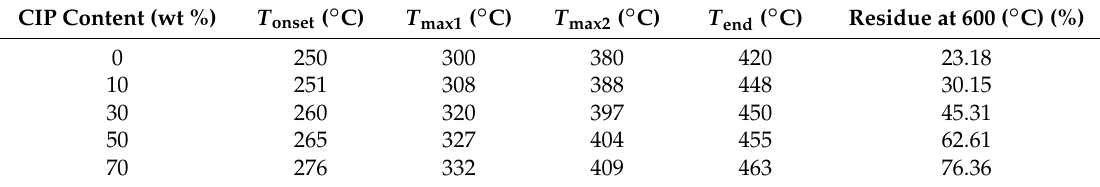
Table 2. Thermal degradation temperatures of ENR-based MREs for various wt % of